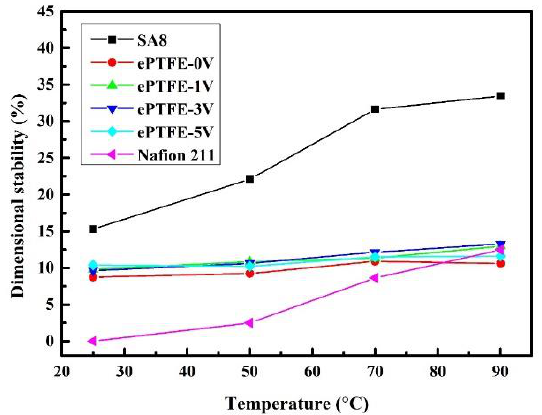
Figure 9. Width stability of ePTFE membranes at various temperatures.